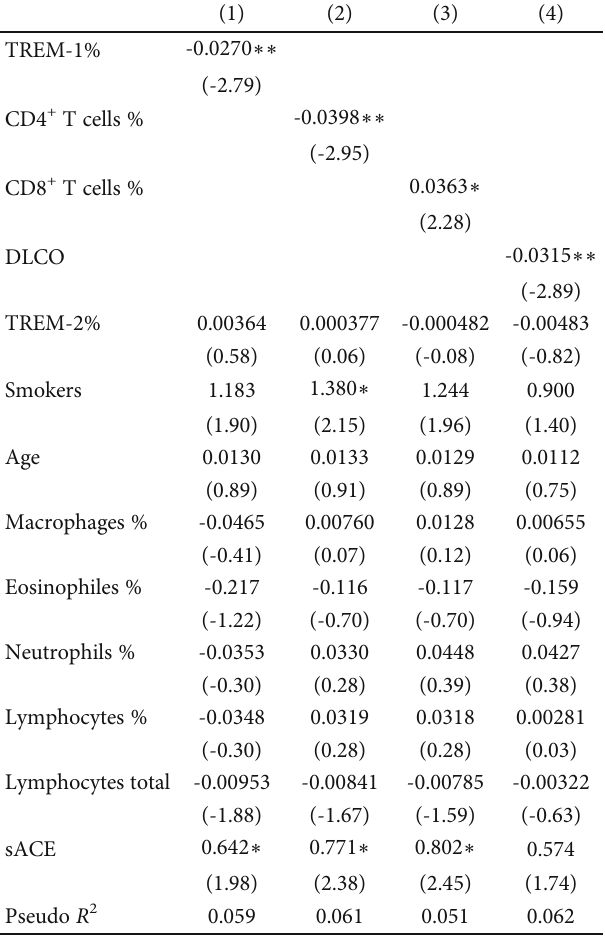
Table 7: Multinomial ordered logit models with dependent variable